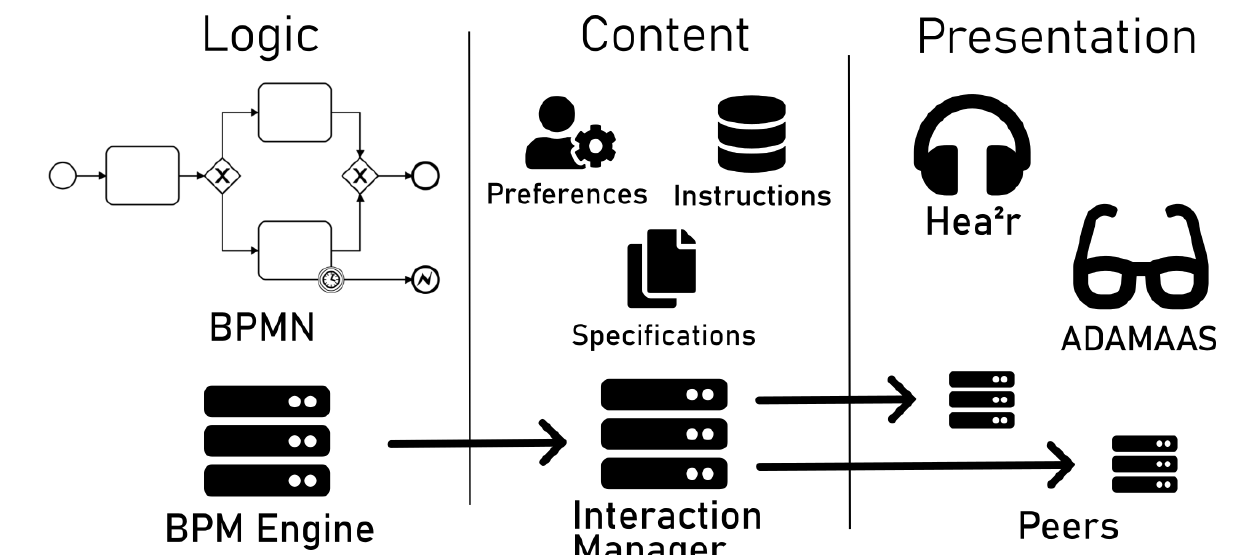
Figure 5. AVIKOM modules are loosely coupled, which eases introspection. The separation of concern (logic, content, presentation) provides flexibility and